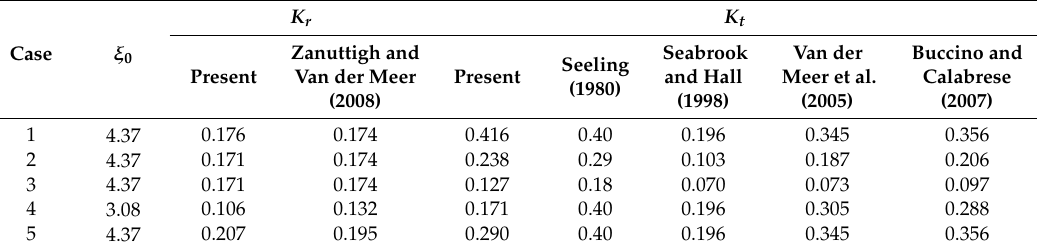
Table 2. Reflection and transmission coe ffi cients for all the ZFB cases of Table